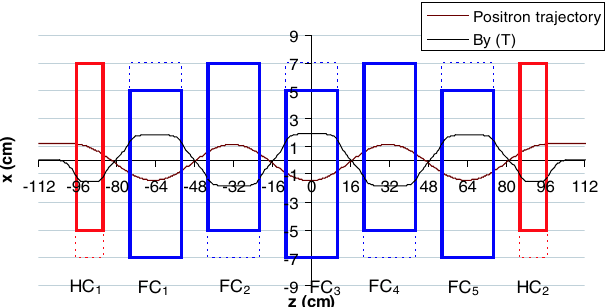
FIG. 7. (Color) Section in the z - x plane of the modified wiggler (solid line). The configuration of the poles before any modifica- tion is also shown (dashed lines).